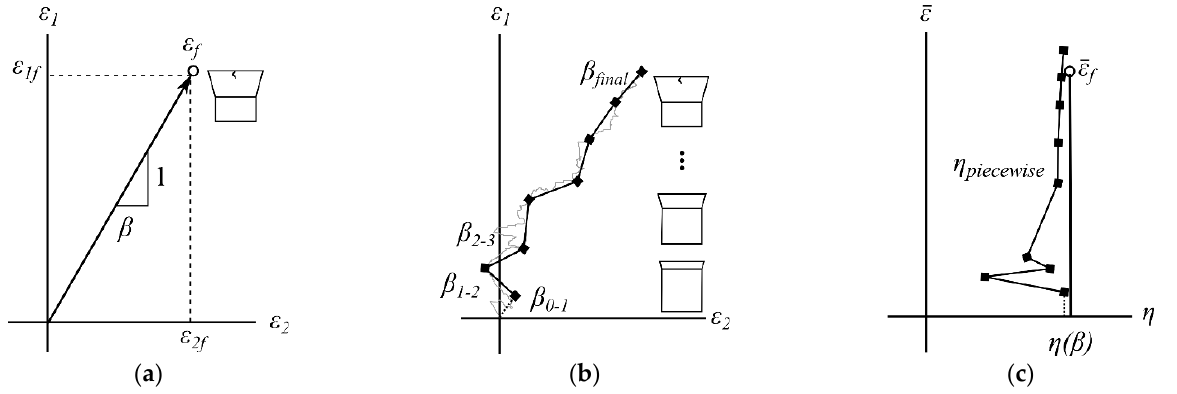
Figure 11. ( a ) Linear, proportional strain path in principal strain space, ( b ) non-proportional strain path discretized through a series of piecewise linear strain paths in principal strain space, ( c ) representation of the strain paths ( a , b ) in the effective strain vs. stress triaxiality space.